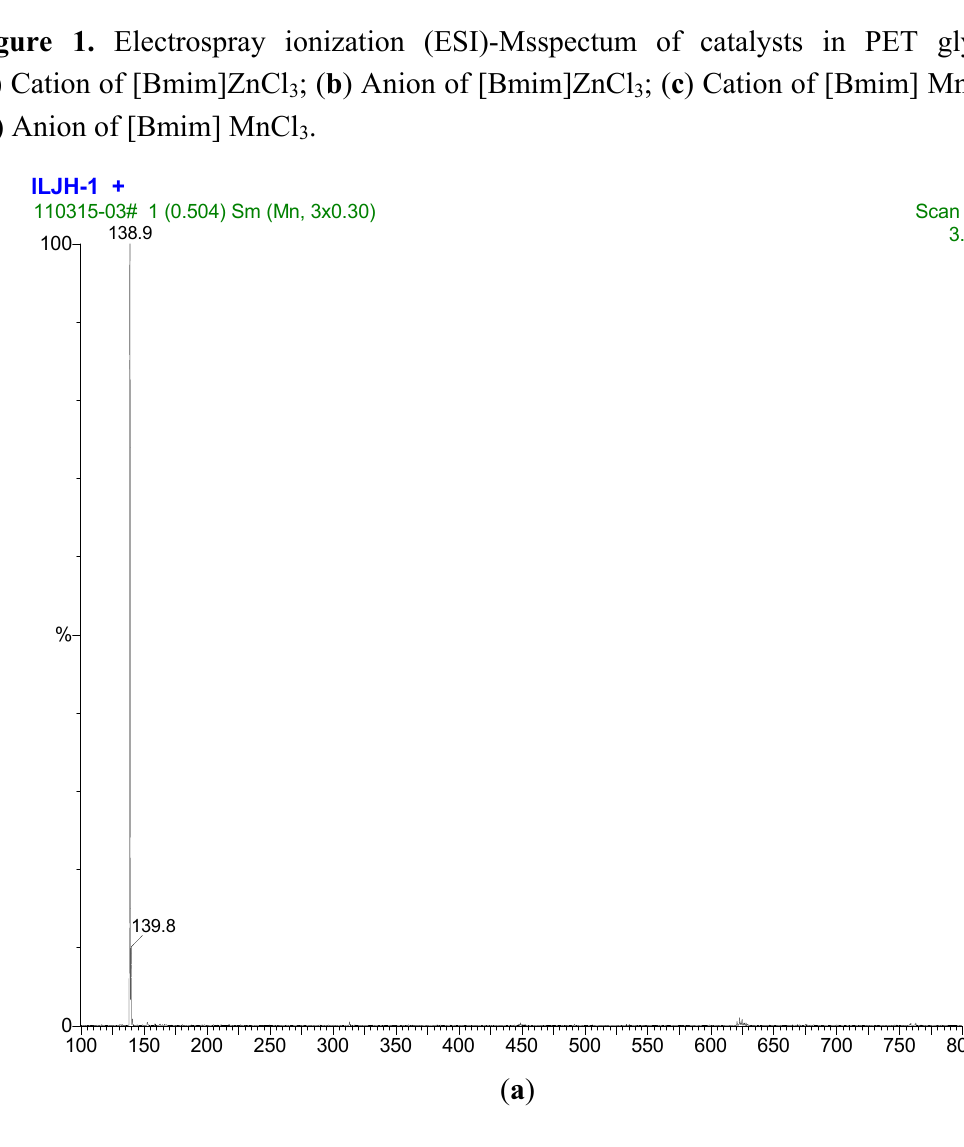
; ( c ) Cation of [Bmim] MnCl 3